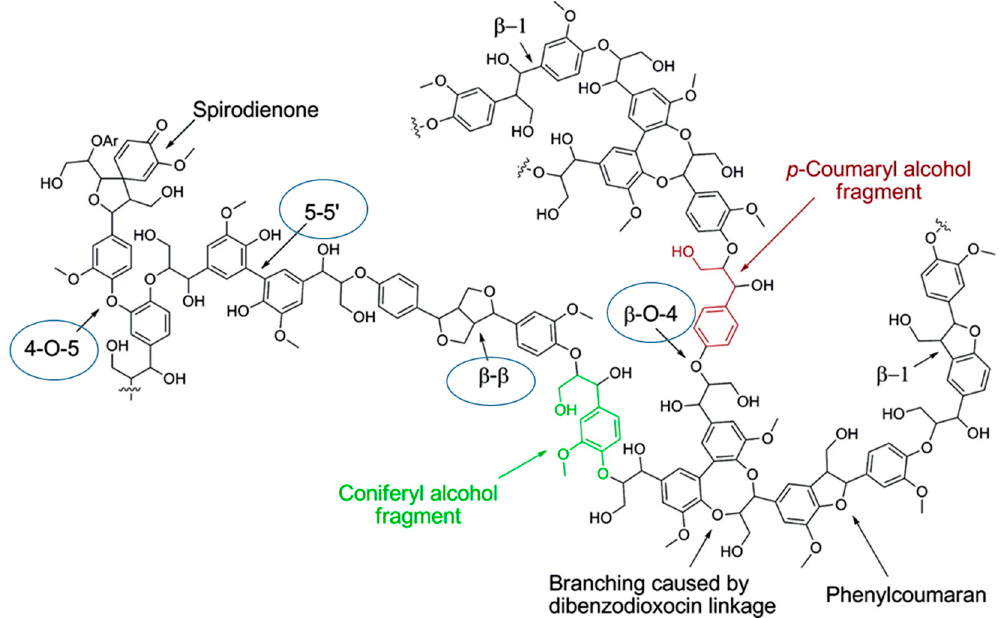
Figure 1. Schematic representation of a softwood lignin structure showing the different linkages. (Reprinted with permission from [5]).